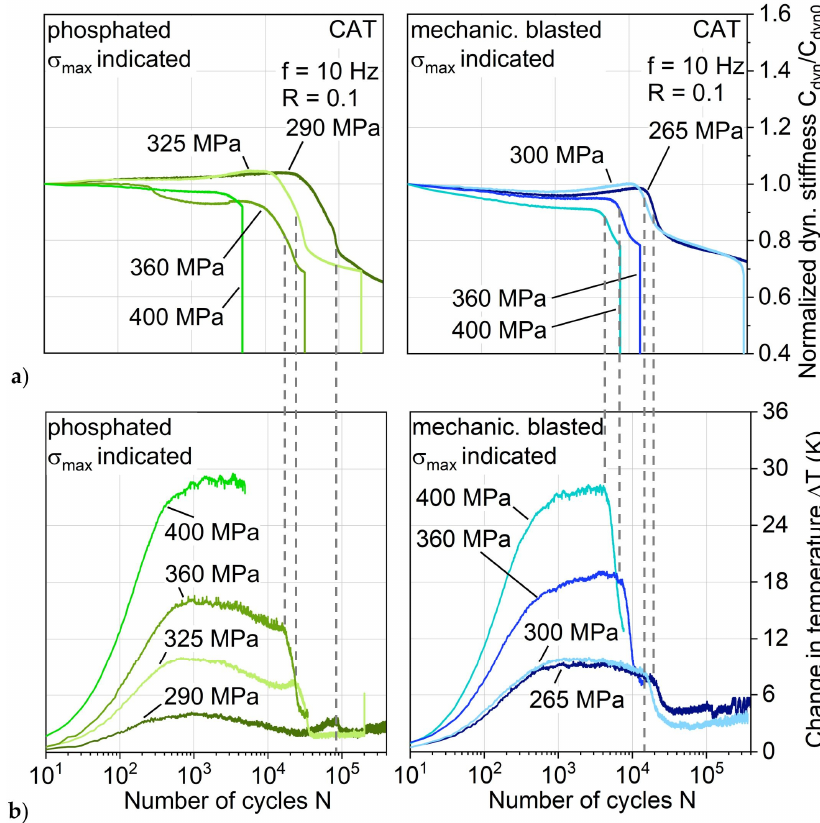
Figure 17. Influence of phosphating and mechanical blasting aluminum surface treatment on ( a ) normalized dynamic stiffness and ( b ) change in temperature (plotted logarithmically) during ( a ) normalized dynamic sti ff ness and ( b ) change in temperature (plotted logarithmically) during constant amplitude tests at a variety of σ max. constant amplitude tests at a variety of σ